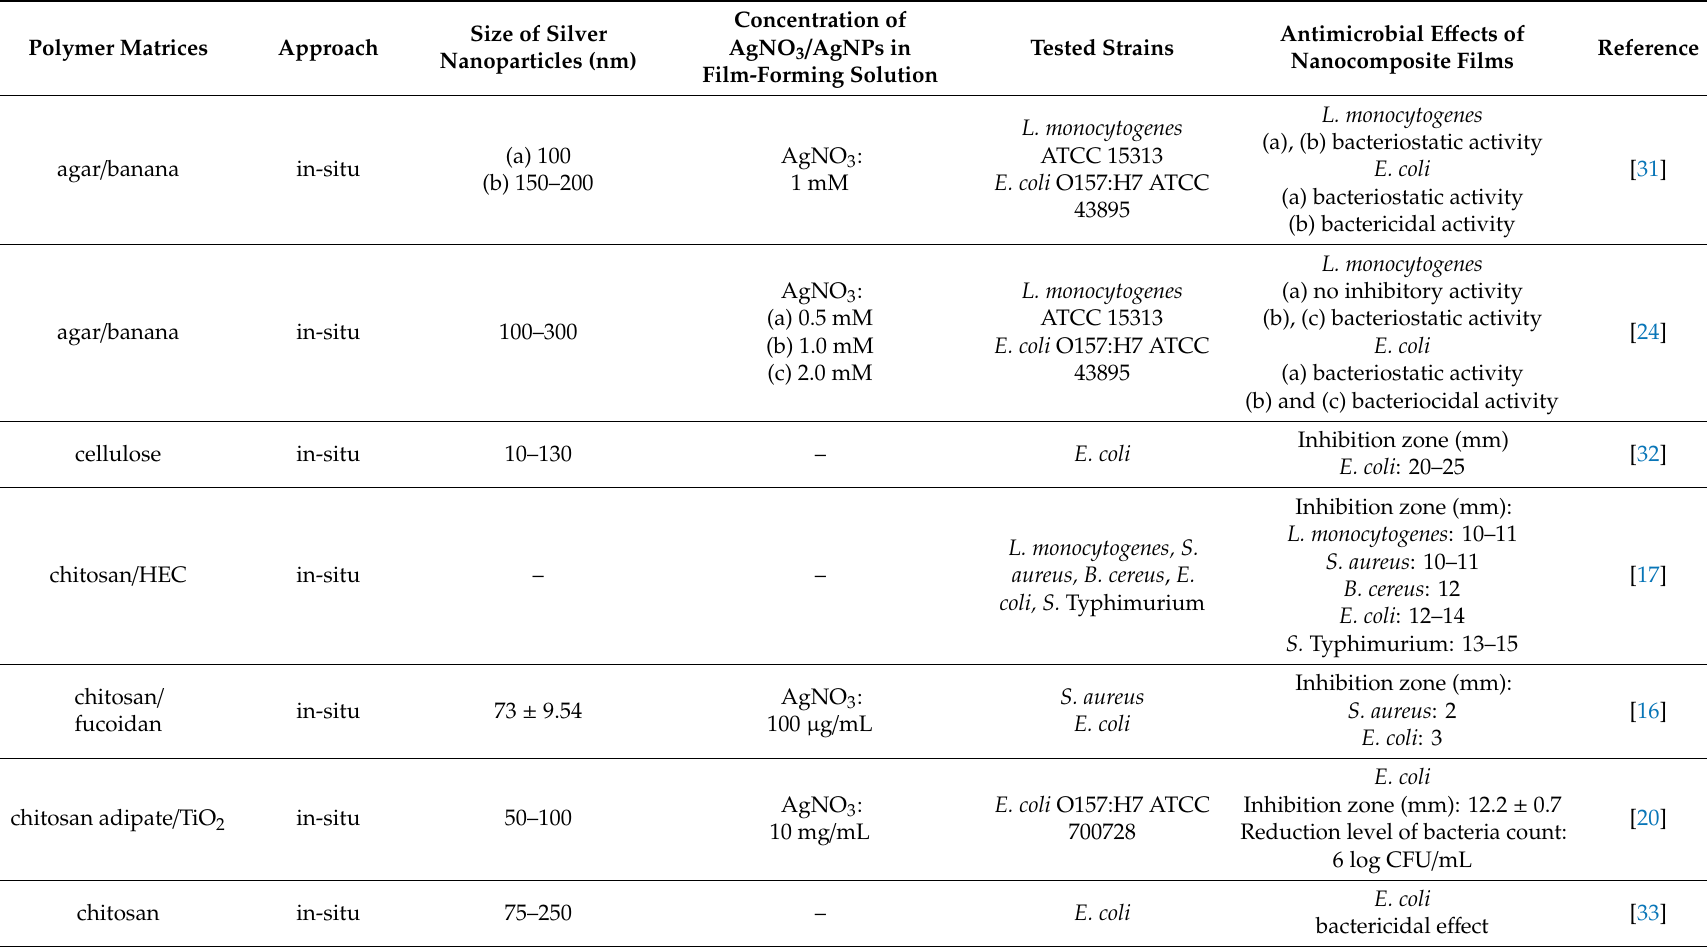
Table 1. Antimicrobial activity of various biopolymer-based materials containing silver